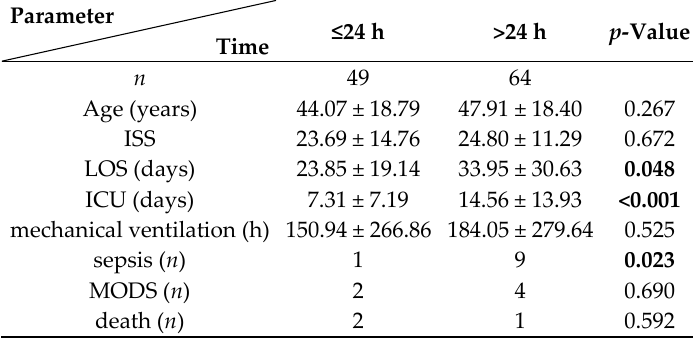
Table 3. Stratification analysis (ANOVA and chi-square test) for the time to surgery ( < 24 vs. > 24 h).